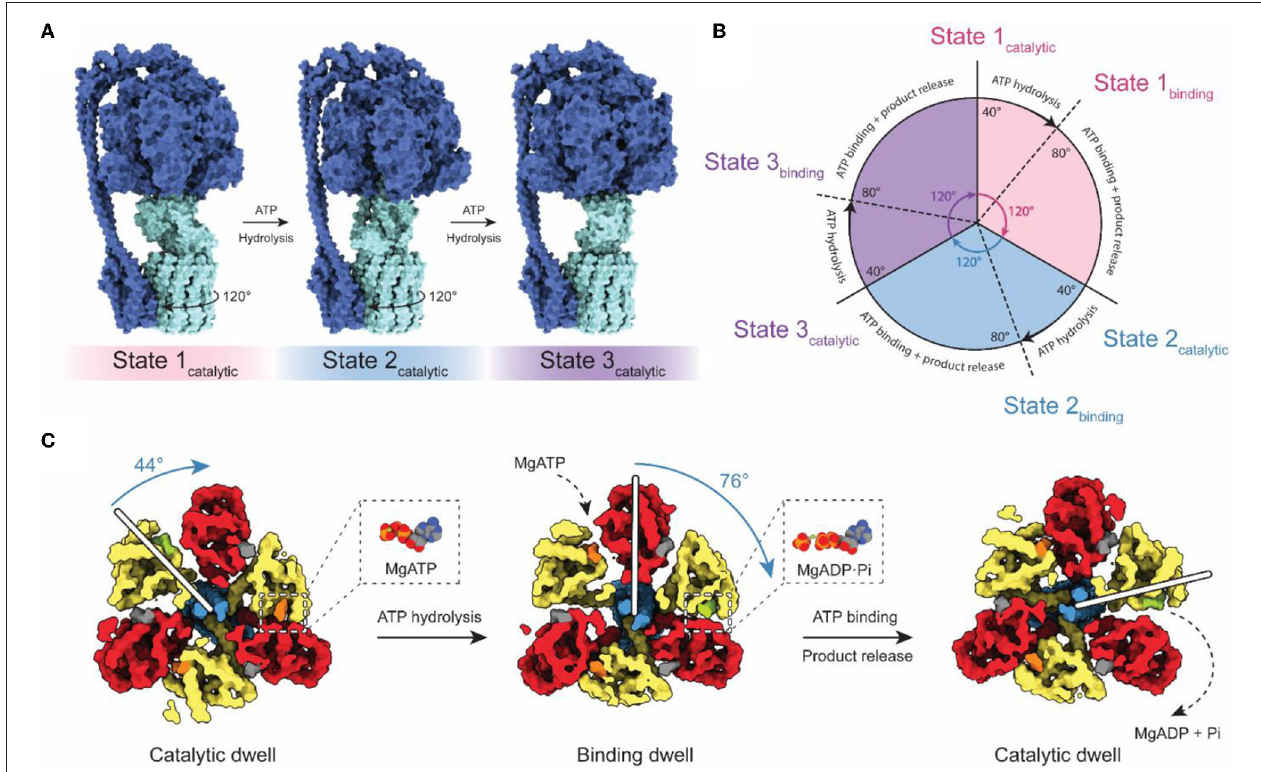
FIGURE 2 | Rotary catalytic mechanism of ATP synthase. (A) Atomic model of Bacillus PS3 ATP synthase showing the three main rotational states (PDB: 6N2Y, 6N30, and 6N2Z) ( Guo et al., 2019). The light blue parts of the complex rotate relative to the dark blue parts. The direction of rotation during ATP hydrolysis is indicated. (B) Diagram of the catalytic cycle of the F 1 region during ATP hydrolysis. (C) Structures of the Bacillus PS3 F 1 complex catalytic substeps (PDB: 7L1R and 7L1Q) ( Sobti et al., 2021). White bars represent the angle of the γ subunit. ATP, ADP, and non-catalytic nucleotides are colored orange, green, and dark gray, respectively. Based on Sobti et al.